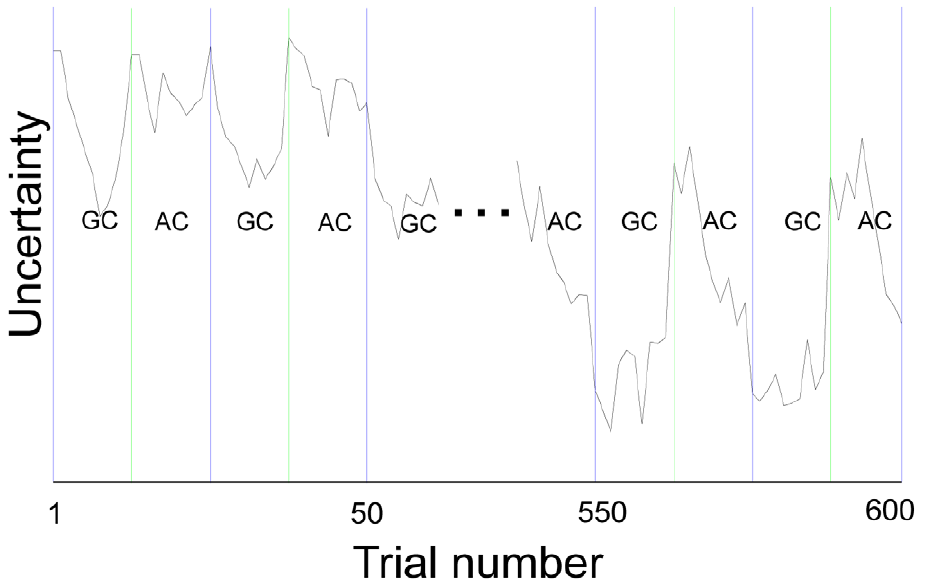
Figure 3. Degree of learning formalized as prior uncertainty about the reinforcement contingencies, in M1. Without evidence of a contextual norm (in the AC) subjects are uncertain about what to do with an unfamiliar person, and must learn quickly. This time-series, convolved with a hemodynamic response function predicted hippocampal fMRI responses (see main text).